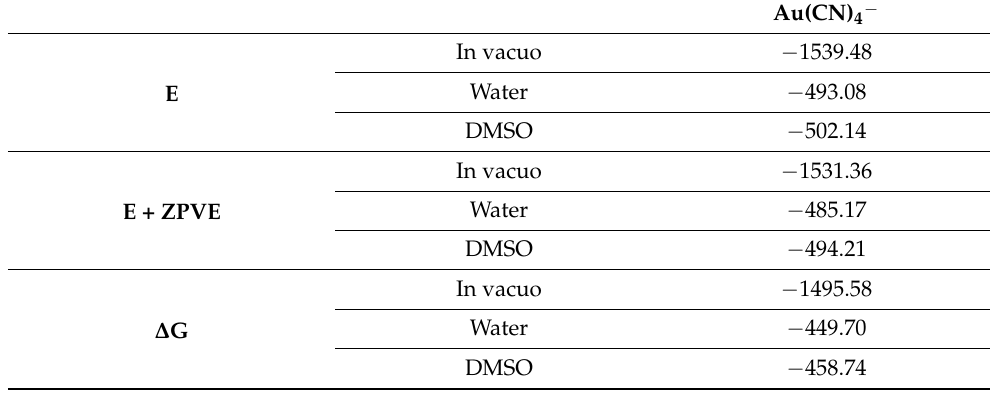
Table 1. Energy (E); energy corrected by the zero-point vibrational energy (E + ZPVE); Gibbs free energy ( ∆ G) of the complex formation of gold(III) tetracyanide. In vacuo—results obtained without solvation. Water and DMSO—results obtained using PCM implicit solvation model. All values are in kcal/mol.